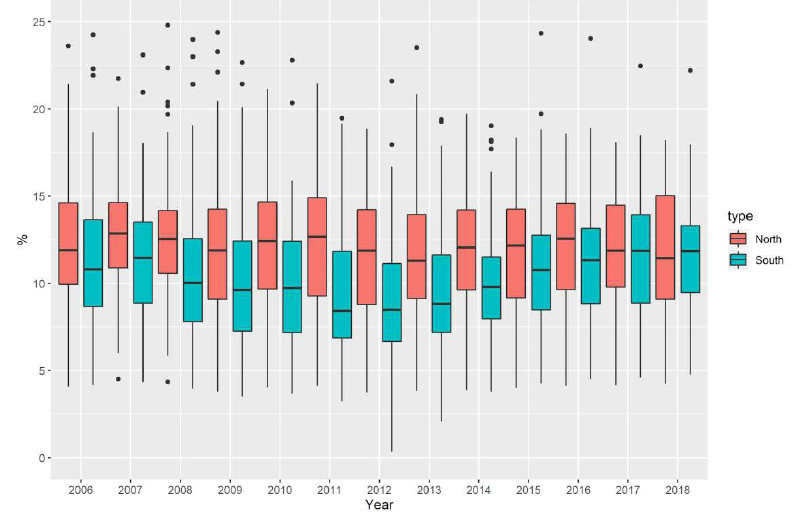
Figure 7. EBITDA/Net turnover